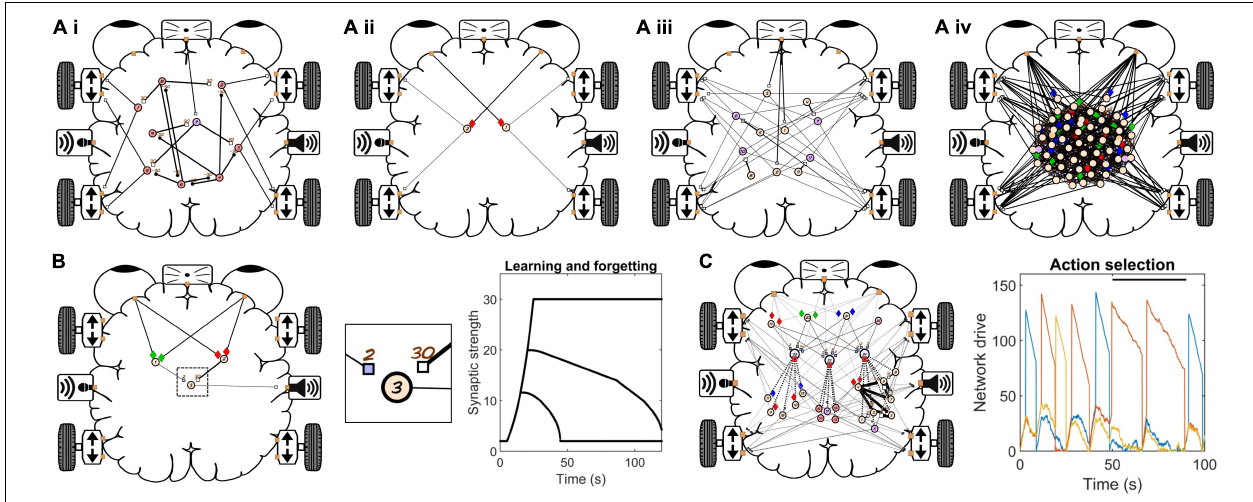
FIGURE 3 | Neurorobot workshop. (A) Brains used to investigate spontaneous behavior (Ai) , directed navigation (Braitenberg vehicle) (Aii) , slow exploration (Aiii) and random networks (Aiv) . In a Braitenberg vehicle, detection of a visual feature in either half of the visual field activates motors on the opposite side of the robot, allowing it to approach a target even if the target moves around. (B) Brain used to investigate Hebbian learning. Plot shows synaptic decay rates for three durations of training. (C) Brain used to investigate adaptive action selection. Plot shows network drive for 3 networks during normal and rewarded (black bar)